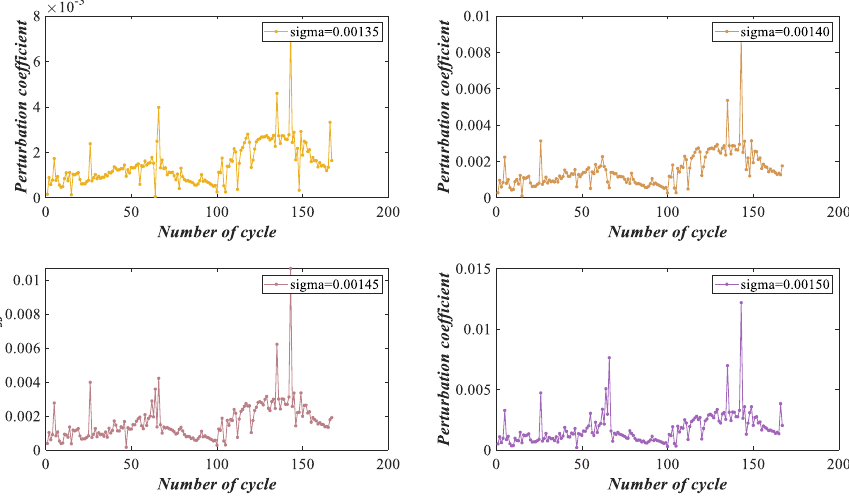
Figure 18. Perturbation coefficients at various perturbation intensities.